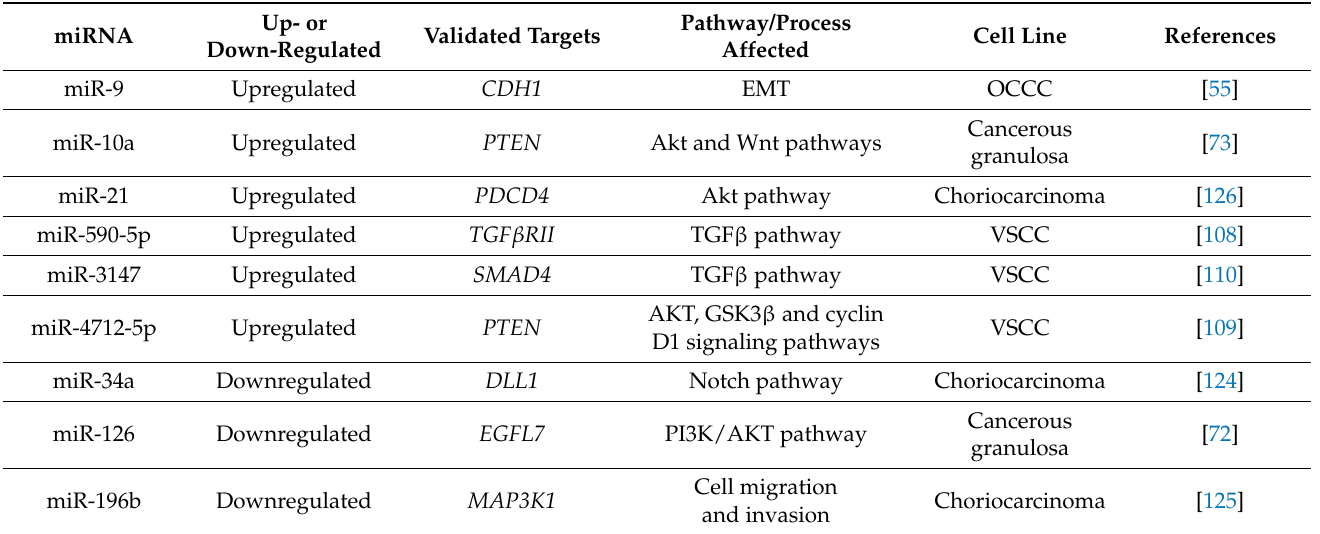
Table 3. Validated mRNA targets and affected pathways of miRNAs relevant in